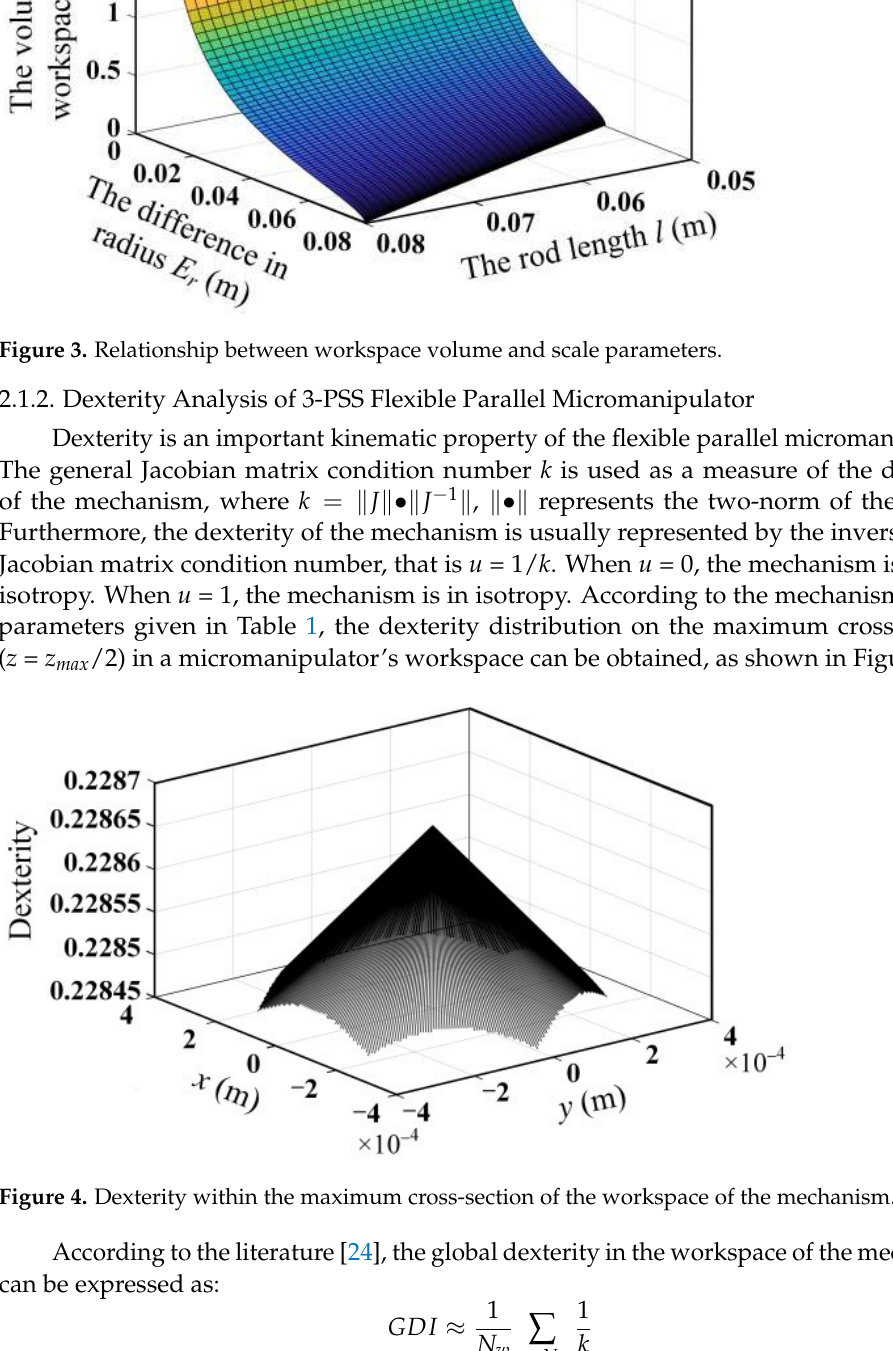
Figure 3. Relationship between workspace volume and scale parameters.